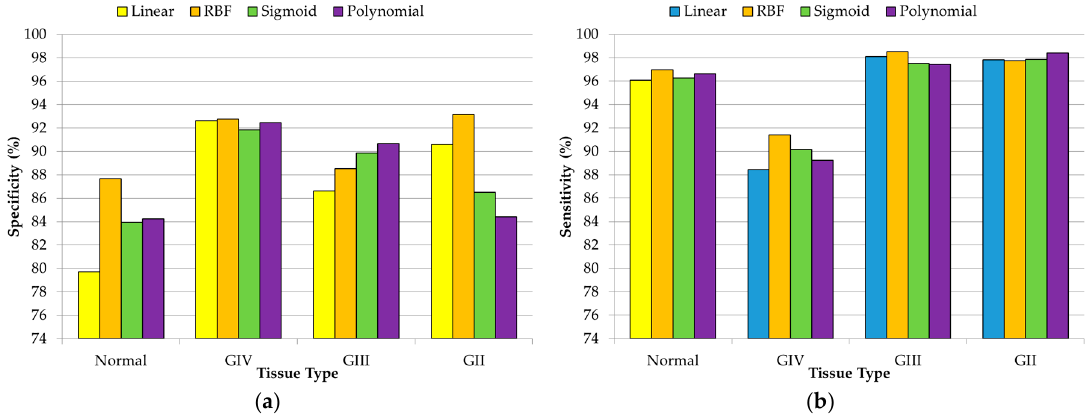
Figure 6. Average specificity ( a ) and sensitivity ( b ) results obtained (using the 10 × 5 cross-validation) with the optimal hyperparameters for each kernel type in the DL2 (normal vs. grade IV vs. grade III vs. grade II).